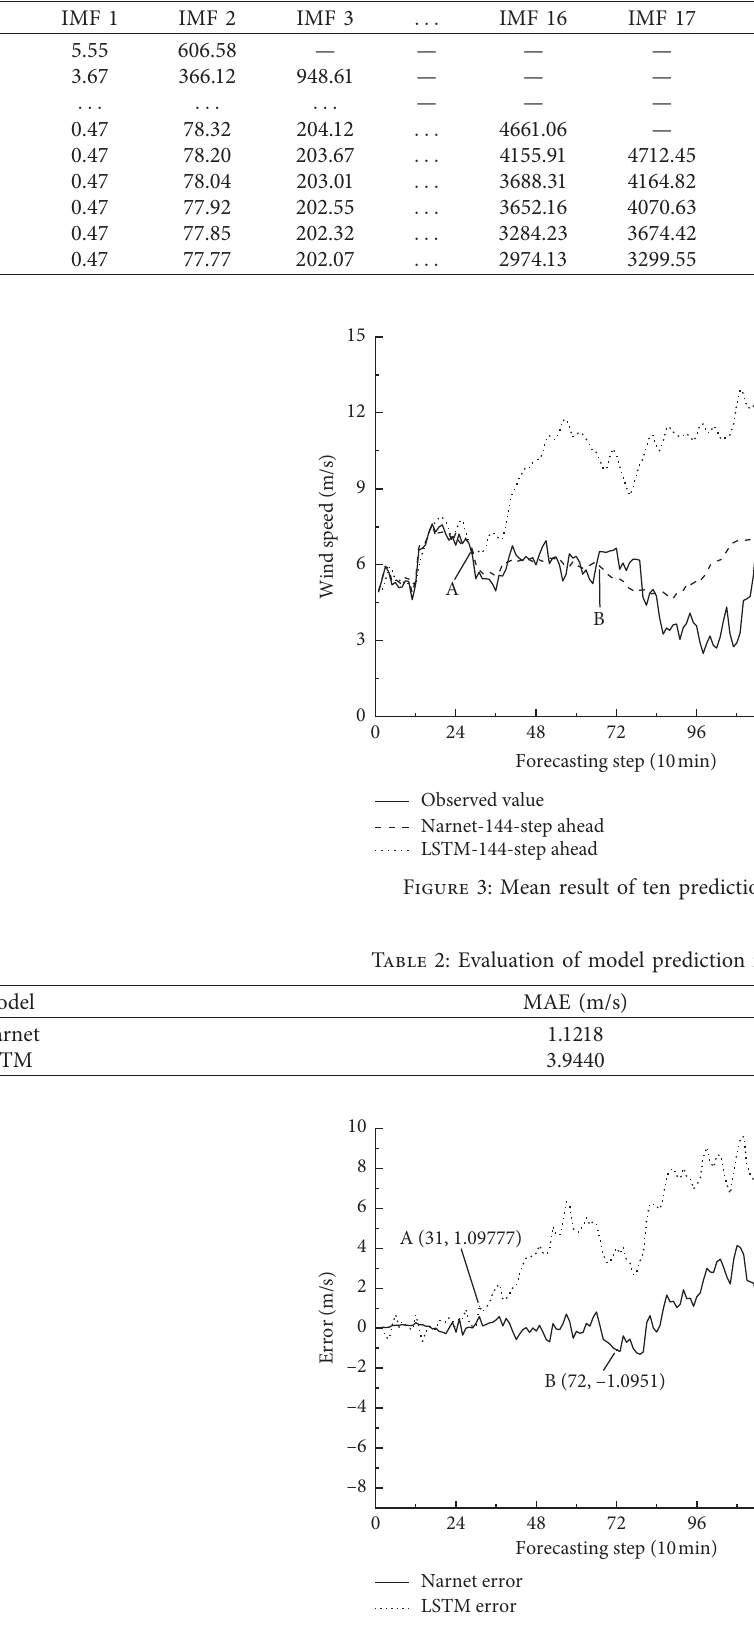
Figure 4: Error of model prediction